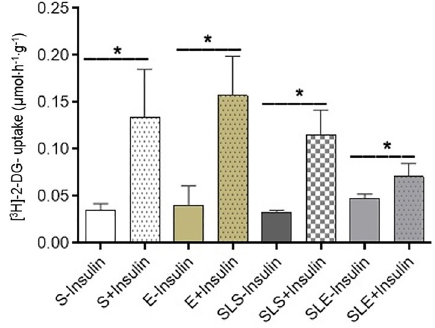
Figure 7. [ 3 H]-2-deoxy-D-glucose (2DG) uptake by isolated incubated soleus muscles obtained from sedentary (S), exercise (E), small-litter sedentary (SLS), and small-litter exercise (SLE) rats. Muscles were incubated in Krebs-Ringer bicarbonate buffer, containing 5.6 mM glucose, 0.1 m Ci/mL 2-DG, for 1 h in the absence or presence of 10 mU/mL insulin. Data are reported as means ± SE (n=8). *P o 0.05